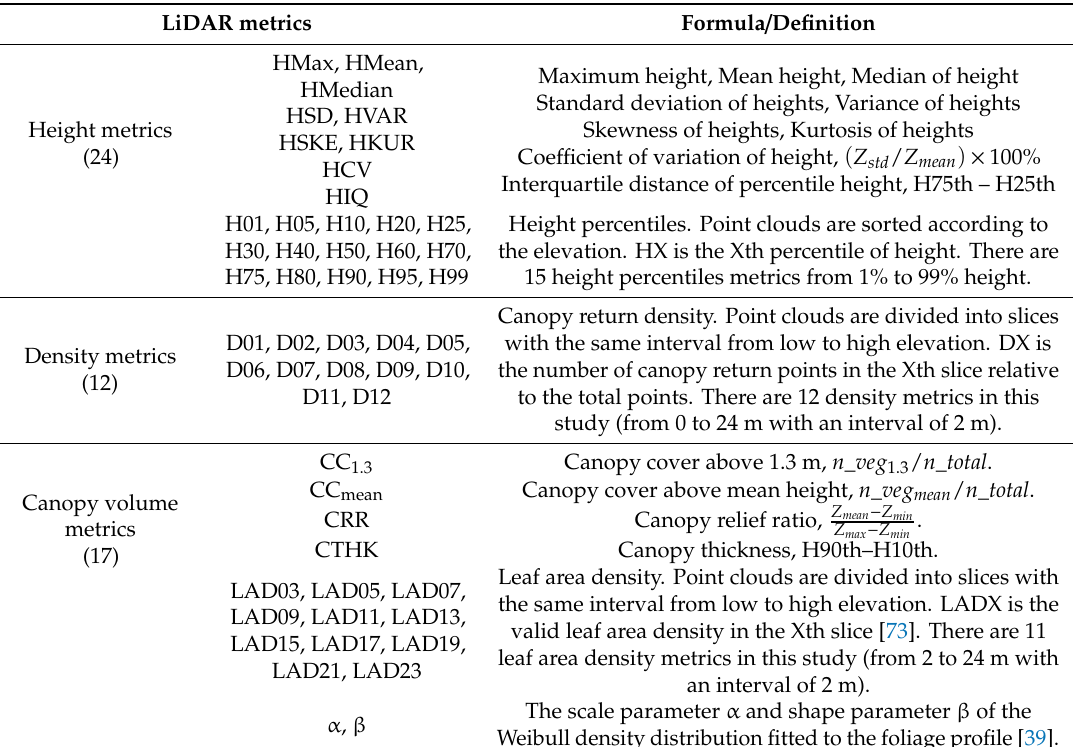
Table A1. The list of metrics derived from UAV-LiDAR point